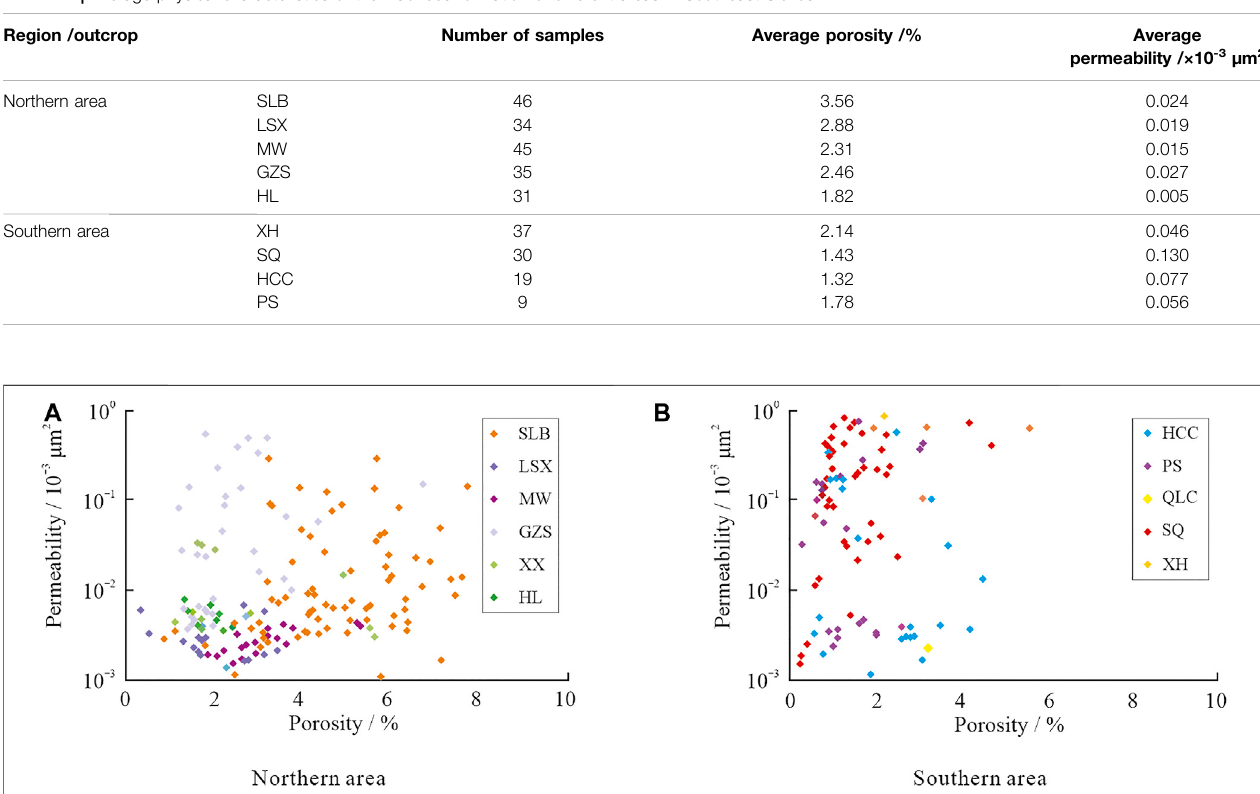
Frontiers in Earth Science |